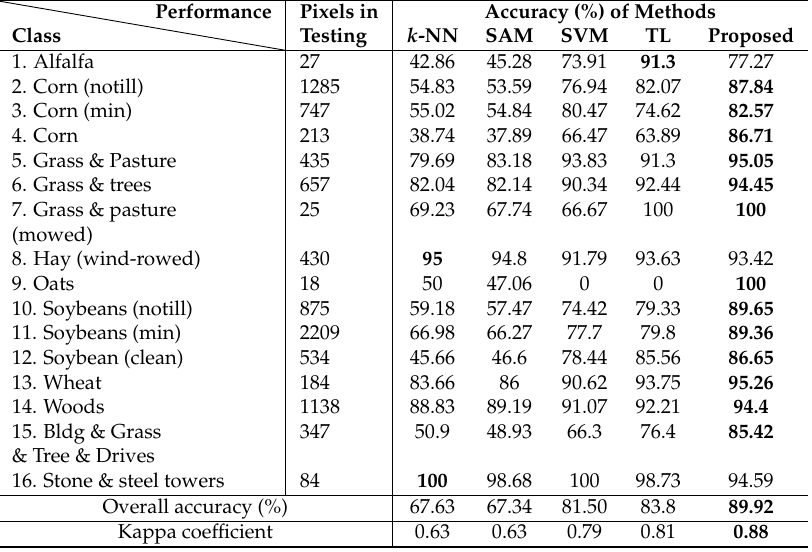
Table 3. Comparison of classification performance, AVIRIS 92AV3 dataset, 10% training set.